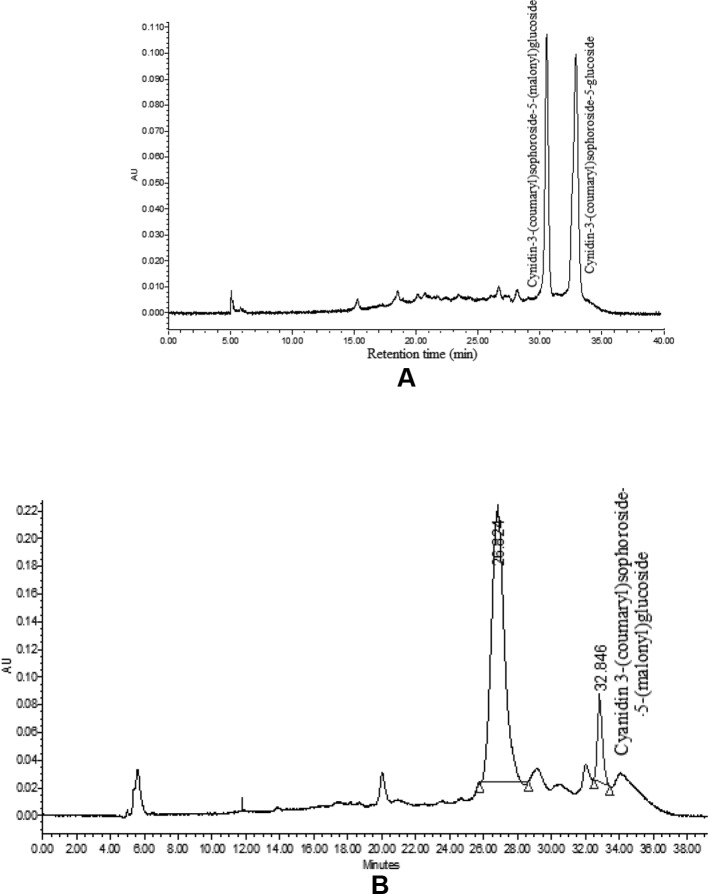
HPLC chromatogram of anthocyanin in ‘PC-1’ (A) and ‘Graffiti’ (B).